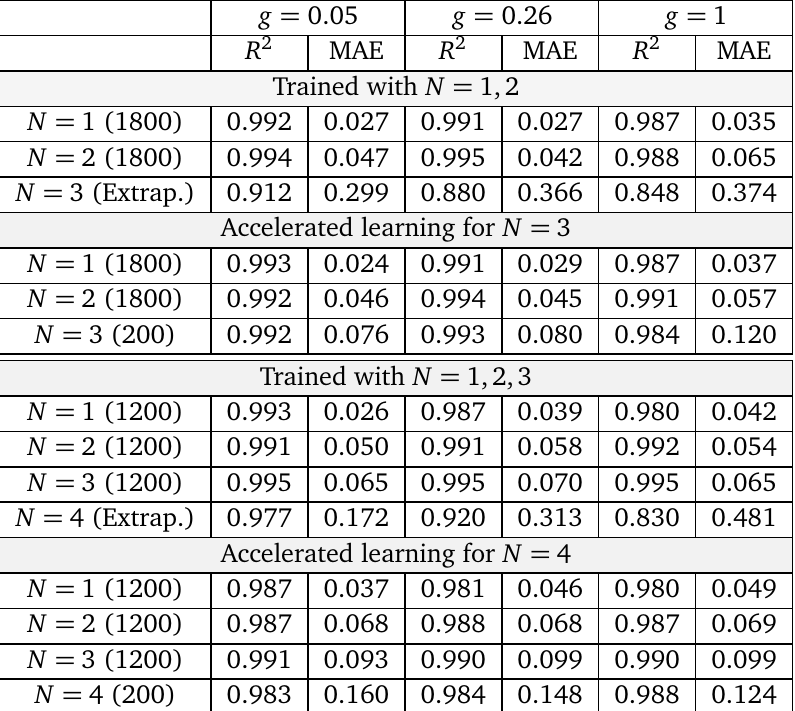
Table 2: Performance of the neural network in the test-case considered in Figs. 3 and 4. The coefficient of determination R 2 and the mean absolute error MAE are reported for three interaction strengths g , considering networks trained on N = 1,2 and on N = 1,2,3. The test results are shown for the particle numbers N included in the training set (number of training instances in parenthesis), for the extrapolations to N = 3 and to N = 4, and for the accelerated learning with additional large-size instances in the training